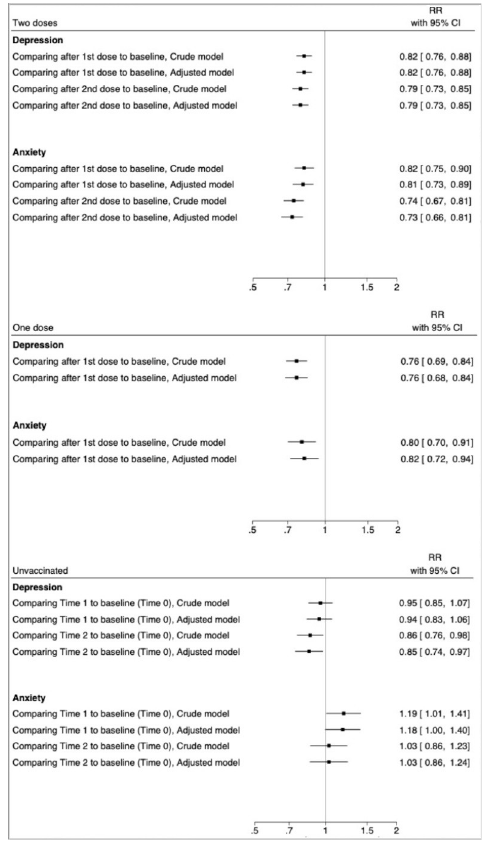
Fig 1. Risk Ratio comparing the prevalence of self-reported depressive and anxiety symptoms after to before vaccination. Risk Ratio (RR) with 95% confidence interval (CI) of depression and anxiety, comparing the prevalence of self-reported depressive and anxiety symptoms after COVID-19 vaccine (1 st or 2 nd dose) to the prevalence before vaccine among vaccinated individuals, and comparing the prevalence of later time points to baseline among the unvaccinated individuals. Unvaccinated individuals include individuals reporting no vaccination or choosing not to report vaccination status. The analyses were performed using GEE models and adjusted for age, sex, recruitment type, body mass index, relationship status, current smoking, number of comorbidities, history of psychiatric disorder, history of COVID-19 infection, and month of baseline survey. The risk ratio is plotted as a box, and the 95% confidence interval as the